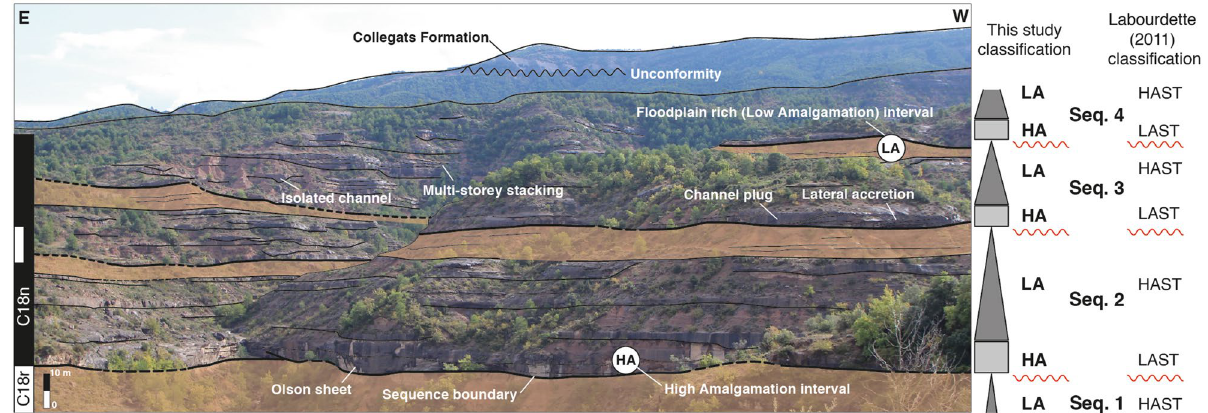
Figure 3. Field view of the studied sequences. This panorama depicts the studied intervals in sequences 2, 3 and 4 (sequence 1 lies below). At the base of the panorama lies a thick floodplain dominated interval terminating the LA interval of sequence 1, and above which lies the High Amalgamation (HA) interval corresponding to the ‘Olson sheet’. Above the HA interval lies the floodplain dominated Low Amalgamation (LA) interval. Several stratigraphic features such as channel plug, lateral accretion, isolated channel, and multistorey stacking pattern have been marked as well. To the top of the panorama lies the upper Eocene–Oligocene Collegats Formation separated from the underlying Escanilla Formation by an unconformity. Note that the HA-LA (High/Low Accommodation) packages used here correspond to the LAST-HAST packages (High/Low Accommodation Systems Tract of Labourdette 35 . An unannotated version of this panorama has been provided in the supplementary material as Figure